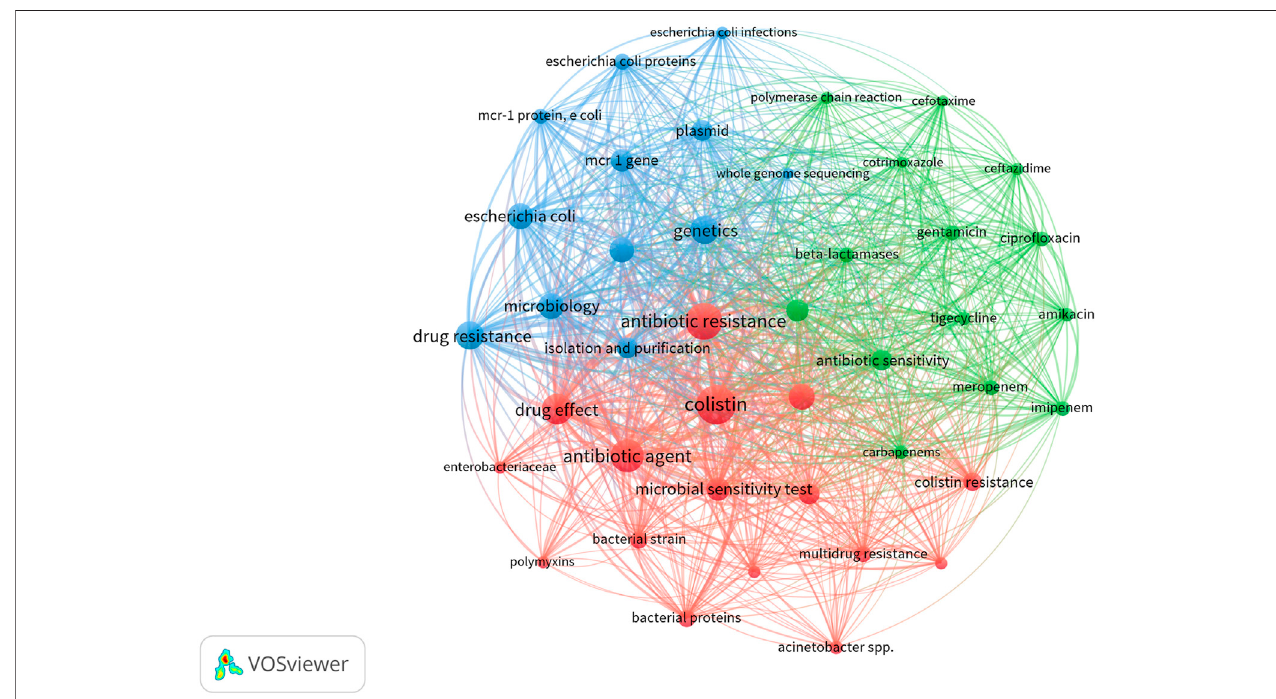
FIGURE3| Researchtopicsclusteredbymappingofco-occurrencesoftermsforpublicationsonpolymyxinresistance(2010 – 2019).Ofthe6,413terms,42terms occurred at least 200 times. The size of the circles represents the occurrences of terms in title/key. The largest set of connected terms consists of 42 terms in three clusters. The three clusters may be interpreted as: “ relationship of polymyxin resistance with public health (red cluster, 16 items) ” , “ other drugs ineffective against multidrug-resistant organisms including polymyxin-resistant pathogens (green cluster, 14 items) ” , and “ genetics of polymyxin resistance (blue cluster, 12 items) ” .